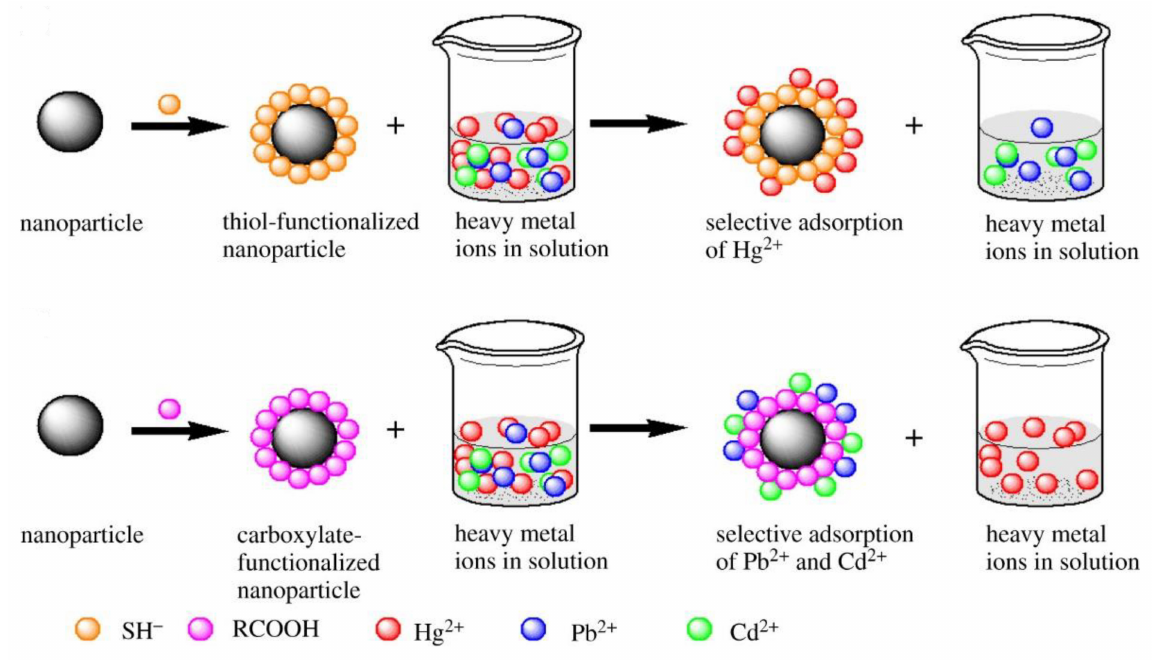
Figure 7. Nanocatalyst in heavy metal remediation